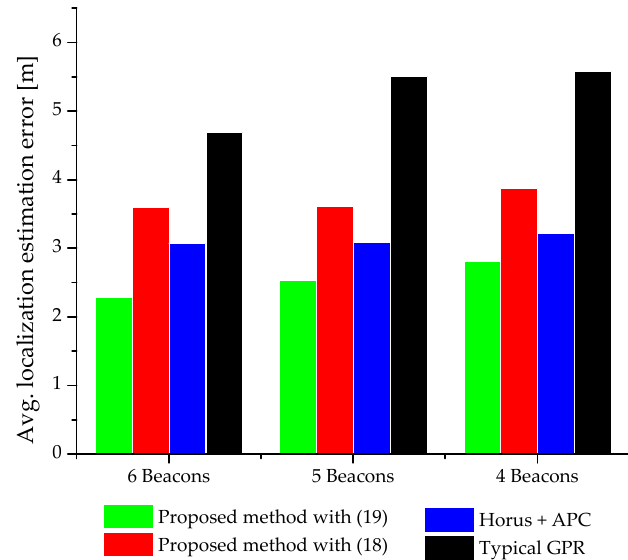
Figure 7. Average localization error from different positioning methods at different beacon density scenarios.